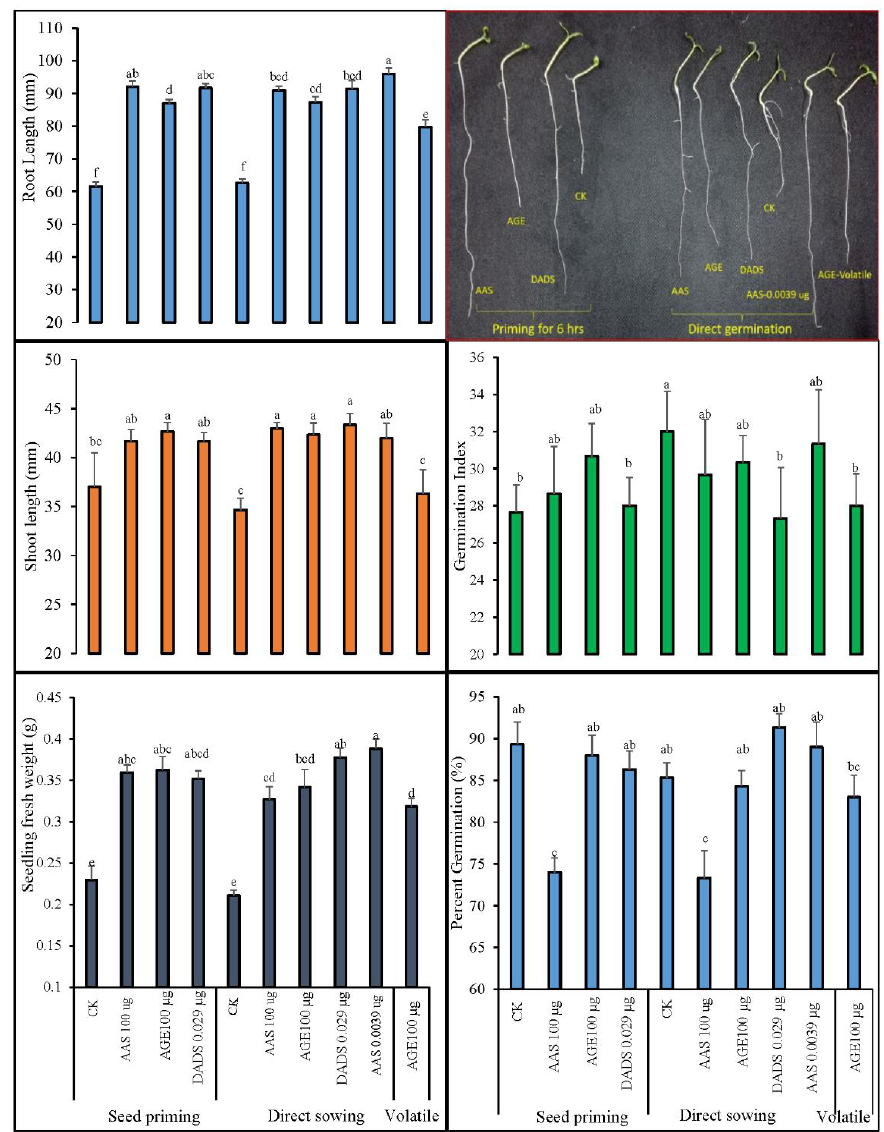
Figure 5. Germination indices and post-germination morphology of tomato after di ff erent treatments of AGE, diallyl disulfide (DADS), and allicin (AAS). Germination percentage, germination index, seedling length (cm), and fresh weight (g) are depicted. Tomato seeds were primed with 100 µ g · mL − 1 AGE, 100 µ g · mL − 1 allicin (AAS), or 0.029 µ g · mL − 1 DADS for 6 h. Distilled water was taken as the control treatment. In another set, tomato seeds were sown directly under the allelochemical e ff ects of these chemicals including 0.0039 µ g · mL − 1 AAS. Additionally, 100 µ g · mL − 1 AGE was also separately provided as the volatile germinating medium to the seeds. Obtained data were subjected to analysis of variance (ANOVA) using factorial design. Di ff erences among the means were calculated with Tukey’s HSD ( p = 0.05). Bars represent mean values and standard errors for four replicates. Means followed by the same letters bear no significant di ff